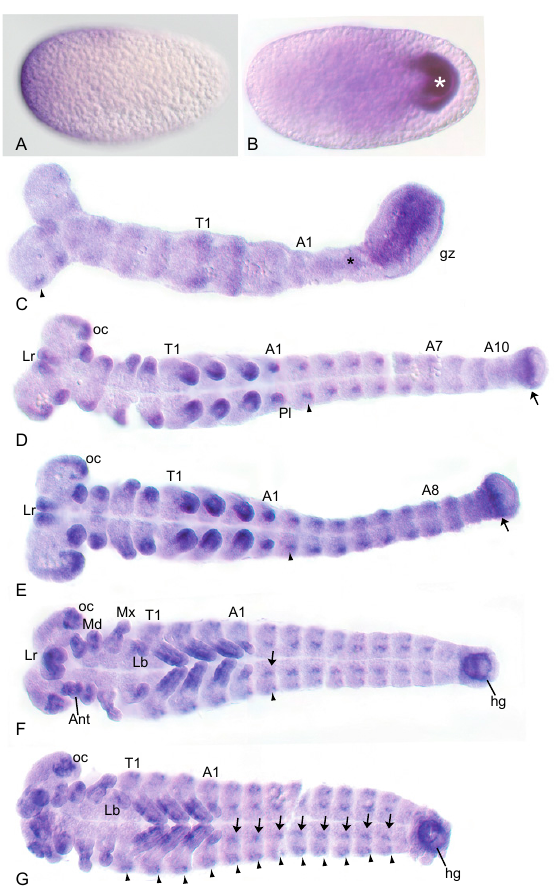
Figure 1. Tc-axin shows a distinct, dynamic expression pattern throughout embryonic development. Tc-axin -mRNA localisation by in-situ hybridisation in wild-type embryos. ( A ) Early cleavage stage embryo with asymmetric anterior expression of Tc-axin mRNA (anterior points to the right). ( B ) Gastrulating embryo (ventral view) with strong upregulation of Tc-axin expression in the posterior invaginating cells (star). ( C ) Embryo undergoing germband extension. A longitudinal Tc-axin domain within the growth zone shows slight upregulation at its border. Weak expression is seen along the midline within the presegmented region (star). In addition, segmental stripes within thoracic segment 1 and 2 and spotted domains (arrowhead) within the head are visible. ( D , E ) Fully segmented embryos with expression of Tc-axin in the distal parts of the head-, gnathal- and thoracic appendages and in the pleuropodia, the appendages of abdominal segment 1. Within each abdominal segment a pair of axin -expressing cells become apparent (arrowhead). Arrow marks cells likely belonging to the hindgut anlage. ( F , G ) In the retracting germband, Tc-axin is expressed ventrally in the thoracic legs while in the other appendages no regionalized expression is seen. Expression strength diminished in the maxillae (Mx) and the labral appendages (Lr). During formation of the hindgut (hg), Tc-axin was seen around the future proctodeal opening. Within each abdominal segment as well as in the thorax, a further axin expression domain marks a group of lateral cells (arrowhead) in addition to axin -positive cells near the midline (arrow). In the fully segmented embryo, the ocular region of the head (oc) permanently expresses Tc-axin ( D – G ). A: abdominal segment; gz: growth-zone; hg: hindgut; Lb: labium; Lr: labrum Md: mandible; Mx: maxilla; oc: ocular segment; Pl: pleuropodium. 3.2. Reduction of Tc-axin Function Results in Anterior Truncated, Mild Bicaudal and Symmetric Double Abdomen Embryos